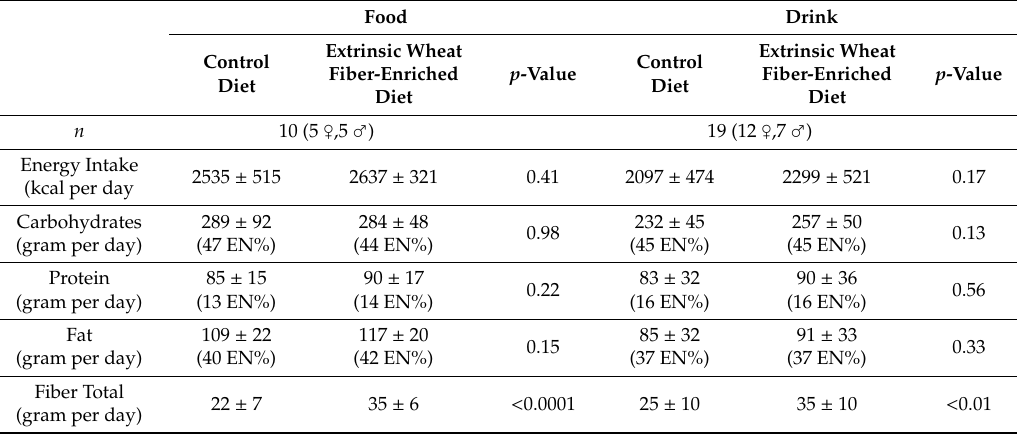
Table 3. Macronutrient